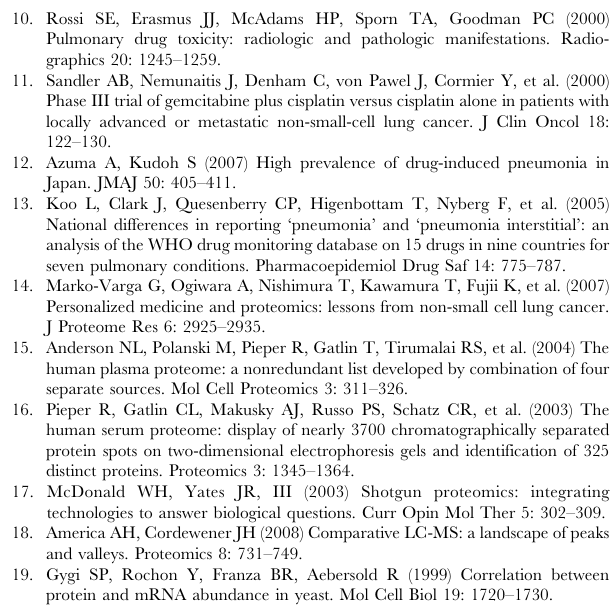
Figure S6 Western blot images from 12 subjects on 9 selected differentially expressed proteins. 1 m g (0.1 m g for serpin A1) of depleted human plasma proteins of study samples (6 ILD cases and 6 controls) were separated by SDS-PAGE, Figure S7 Significance levels from proteins, constituent peptides, and acute phase pathway intensities, adjusted for clinical variables. p-values for the proteins are shown by red stars, p-values for individual peptides are shown by points, and the distribution of these for each protein is shown by a boxplot. In each boxplot, the upper and lower sides of the box represent the higher and lower quartile values (Q3 and Q1), respectively. The black bar in each box represents the median value. The p-value for the acute phase pathway is represented by the dashed line; boxplots for proteins in the acute phase response pathway are shaded. A1AG1 = alpha-1-acid